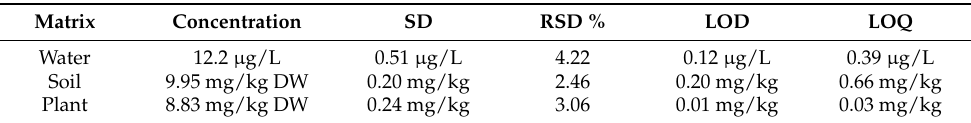
Figure 1. Plot of Li cps in contrast with RPq during method optimization using ICP-MS spectrometer (Perkin–Elmer). A value of RPq = 0.22 was used for all Li measurements. The precision data for the three sample matrixes are given in Table 3. The obtained results indicate acceptable precision in all cases, with an RSD of 4.22% for the water samples, and 2.46% and 3.06% for soil and plant samples, respectively. Table 3. Precision data (standard deviation-SD, and relative standard deviation-RSD), limit of detection (LOD), and limit of quantification (LOQ) for Li determination in water, soil, and plant sample matrixes using Elan DRC II ICP-MS spectrometer.